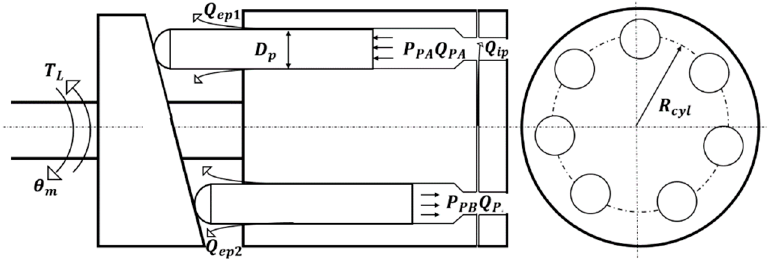
Figure 2. Schematic of a fixed displacement piston pump. The pump consists of a cam, a shaft, a cylinder block, a cylinder valve, and cylinder rods and rod shoes.